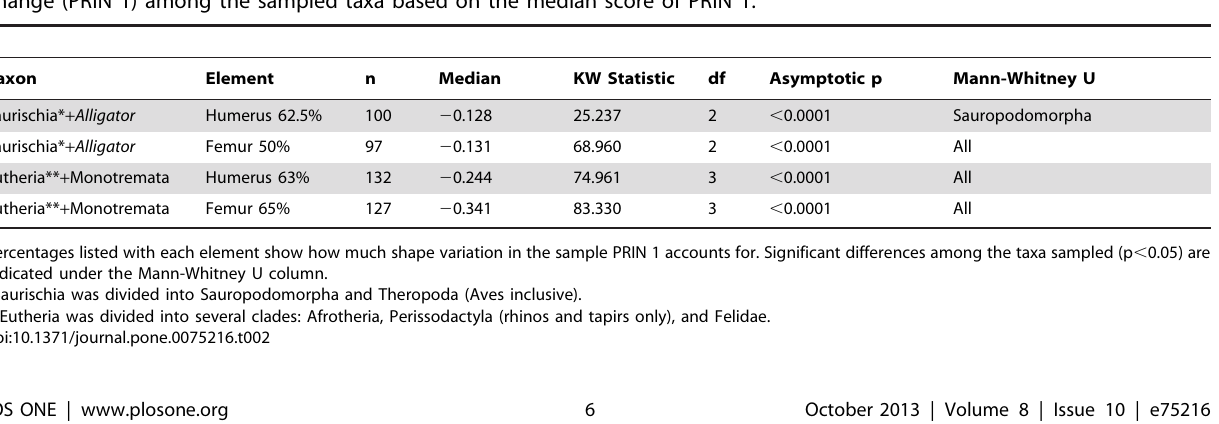
Table 2. Kruskal-Wallace and pair-wise Mann-Whitney U non-parametric tests for significant differences in maximum shape change (PRIN 1) among the sampled taxa based on the median score of PRIN